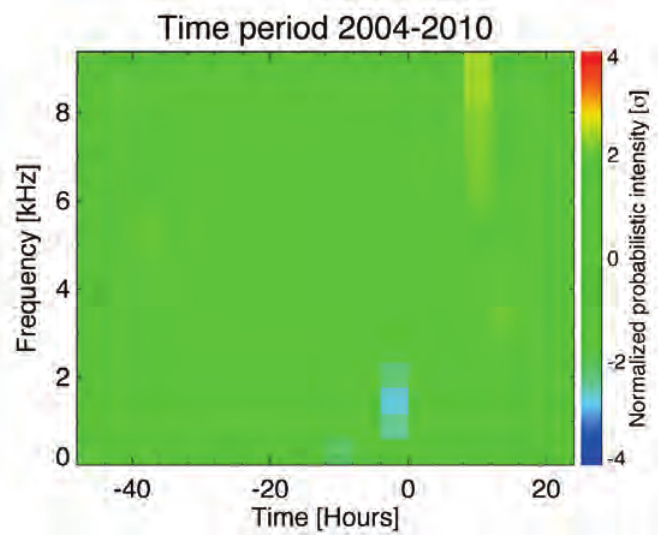
Figure 1. Frequency-time dependence of the normalized probabilistic intensity (see text) obtained from the night-time electric field data measured within 330 km from the epicenters of earthquakes with magnitudes ≥ 5.0 and depth ≤ 40 km.